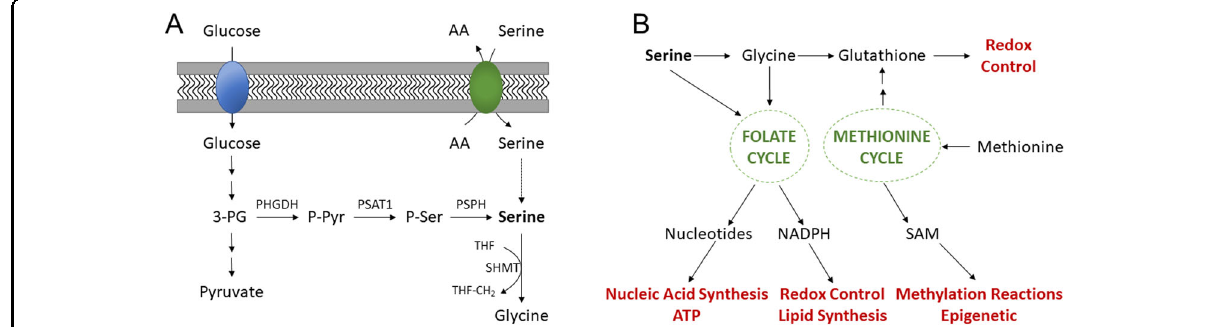
Fig. 1 The serine synthesis pathway (SSP) and downstream anabolic pathways. A Serine synthesis pathway. Serine is shown to be both imported from the extracellular space by amino acid exchangers and also synthesised de novo from glucose. The fi rst rate-limiting enzyme, PHGDH, oxidises 3-phosphoglycerate (3-PG) using NAD + cofactor to produce phosphohydroxy pyruvate (P-Pyr); secondly, phosphoserine aminotransferase (PSAT1) transaminates P-Pyr to phosphoserine (P-Ser) using glutamate (Glu) as the nitrogen donor; lastly, phosphoserine phosphatase (PSPH) hydrolyses P-Ser to serine. Serine is directly incorporated into lipid head groups and proteins. Serine-derived glycine and folate one-carbon units contribute to nucleotide synthesis [adapted from 12]. B The role of serine in downstream anabolic pathways. Serine is a crucial contributor of one carbon units feeding into one carbon metabolism, the folate cycle and the methionine cycle. One-carbon units donated as a result of serine metabolism are used in the anabolic synthesis of cellular building blocks, co-factors and reducing factors. This fi gure shows the downstream anabolic pathways which use serine derivatives, and the cellular functions (red) which they support, such as biomolecule synthesis, maintenance of cellular homoeostasis, redox reactions and post-translational modi fi